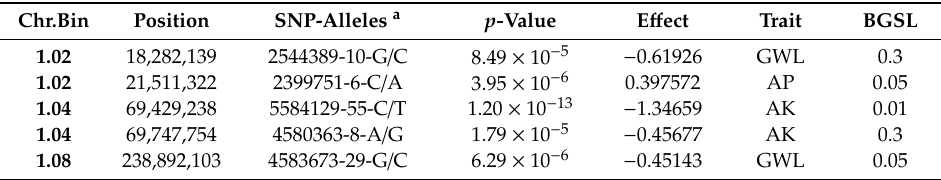
Table 3. List of the 62 quantitative trait nucleotides (QTNs) associated with resistance to fall armyworm (FAW) damage and maize weevil (MW)